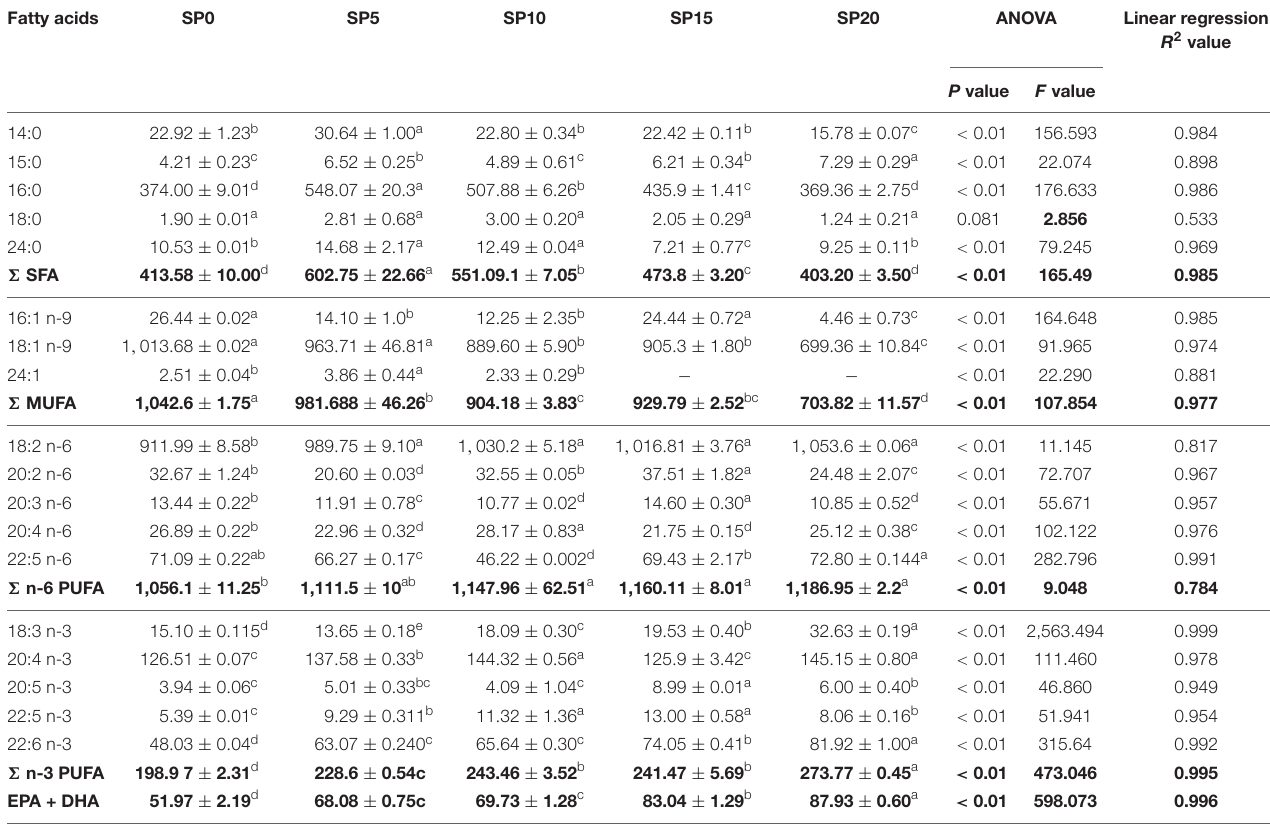
TABLE 5 | Fatty acid compositions (mg/100 g, wet weight) of five different diets-fed Cyprinus carpio . Fatty acids SP0 SP5 SP10 SP15 SP20 ANOVA Linear regression